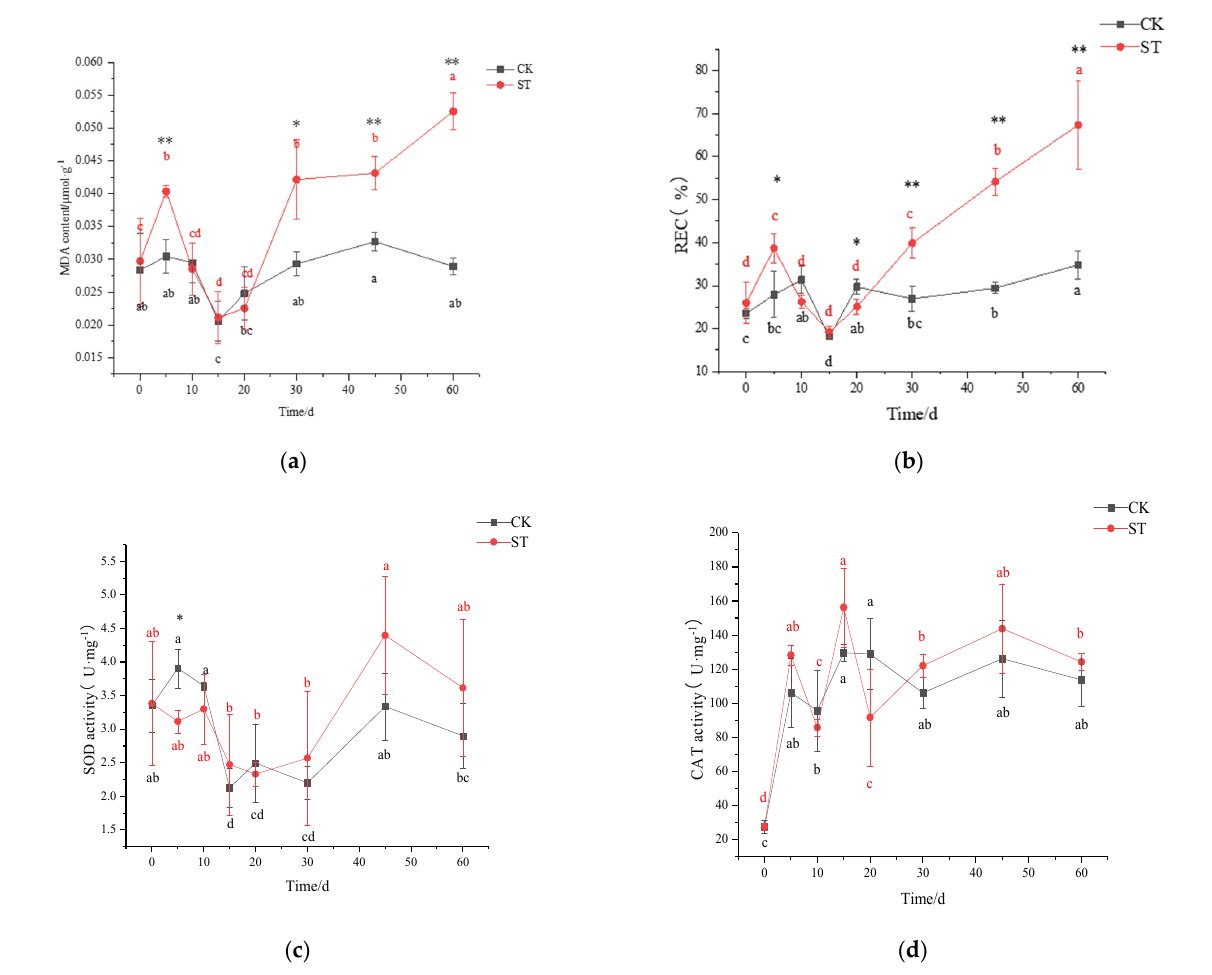
Figure 4. Changing pattern of membrane damage and antioxidant enzyme activity in leaves of C. hongkongensis subsp. tonkinensis under salt stress. ( a ) represents the content of malondialdehyde (MDA), ( b ) represents the content of relative electrical conductivity (REC), ( c ) represents superoxide dismutase activity (SOD), ( d ) represents catalase activity (CAT). * and ** indicate a significant difference between CK and ST at the same time according to the independent ‐ samples t ‐ test ( p < 0.05, 0.01); different lowercase letters indicate significant defenses among tested time within treatment ( p < 0.05) according to one ‐ way analyses of variance (ANOVAs). The same is below.